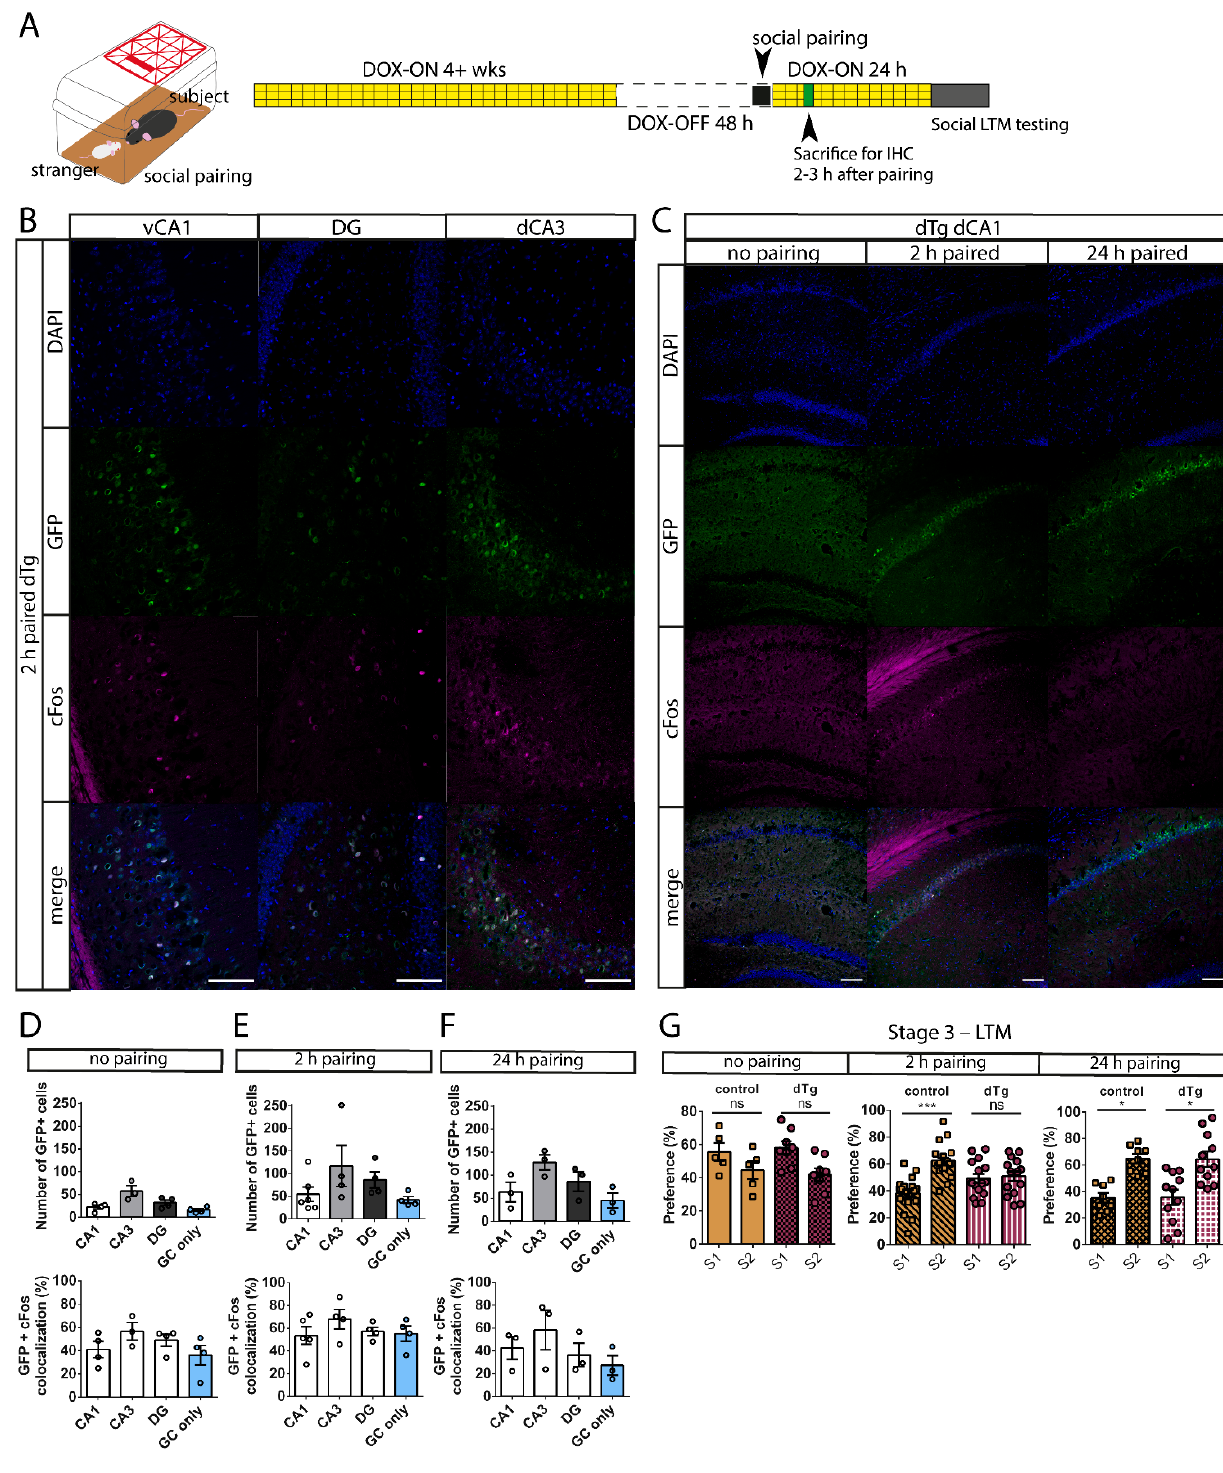
Figure 6. Social pairing-induced expression of mPAK3-GFP proteins impairs social recognition memory. ( A ) Schematics showing home-cage social pairing and DOX administration and removal to induce expression of mPAK3-GFP proteins. ( B ) Sample immunostaining images showing the expression of mPAK3-GFP proteins and overlapping Fos protein expression in the vCA1, DG, and dCA3 of dTg mice after a 2 h social pairing interaction during the DOX-OFF window. Scale bars: 100 µ m. ( C ) Sample immunostaining images showing the effects of different pairing durations during the DOX-OFF window on the mPAK3-GFP expression in the dCA1 of dTg mice. Scale bars: 100 µ m. ( D – F ) Summary graphs showing the number of GFP-positive cells and percentage of GFP and Fos overlap over total GFP-positive cells in various hippocampal regions; ( D ) not paired CA1 n = 4, CA3 n = 3, DG n = 4; ( E ) 2 h paired CA1 n = 5, CA3 n = 4, DG n = 4; ( F ) 24 h paired CA1, CA3, DG n = 3. ( G ) A 2 h but not a 24 h social pairing interaction resulting in a social recognition deficit during stage